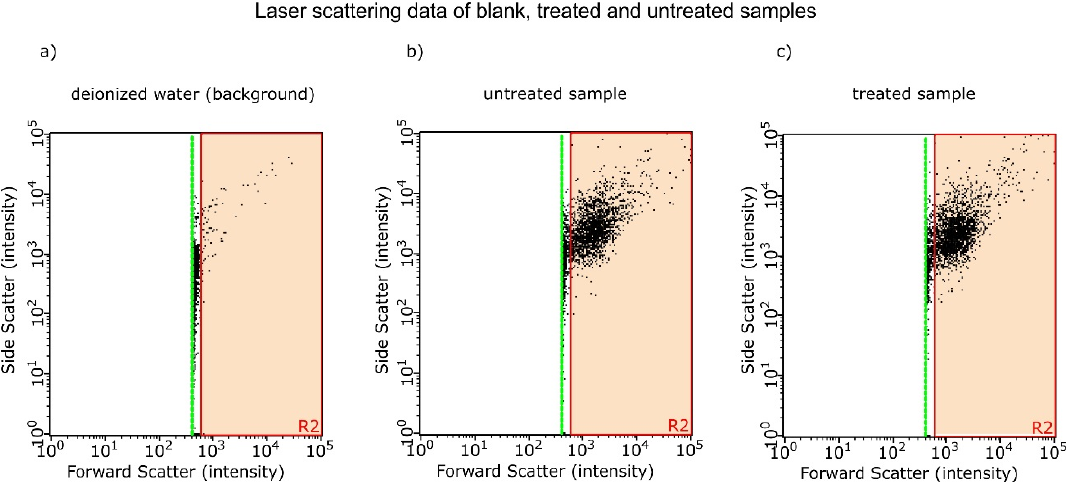
Figure 13. ( a ) Exemplary laser scattering data from deionized water; ( b ) an untreated sample; ( c ) a treated sample showing forward against side scatter intensity. Each dot represents one scattering particle. Only the red area (R2) is evaluated; very weak scatterers between the red area and the green line (detection limit) are considered background noise. Table 6. Number of objects determined by laser scattering in two treated and untreated solutions from 22 samples each.